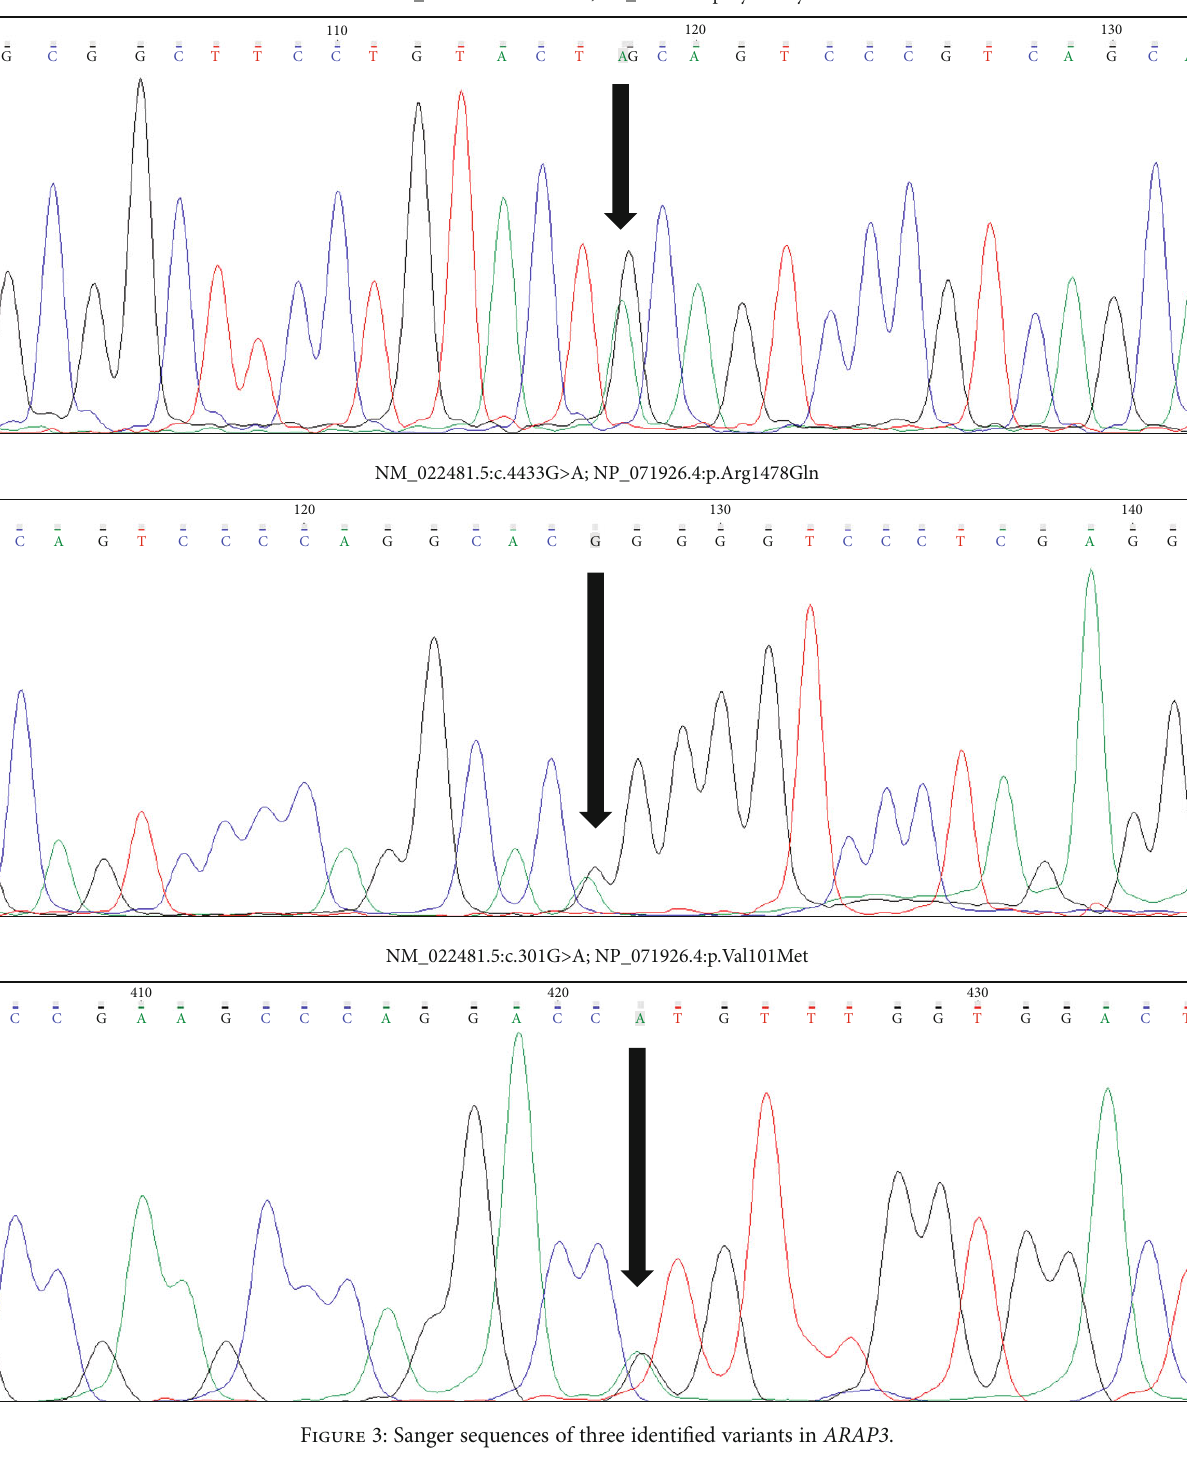
Figure 6. Details of the residues involved in interactions, units are shown in Table 4.